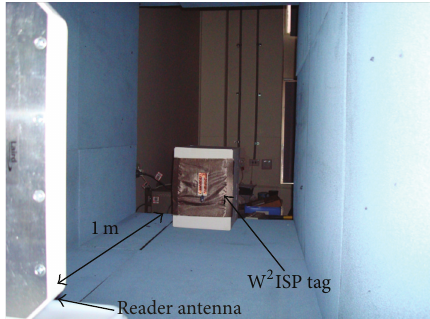
Figure 17: Anechoic box experimental arrangement.